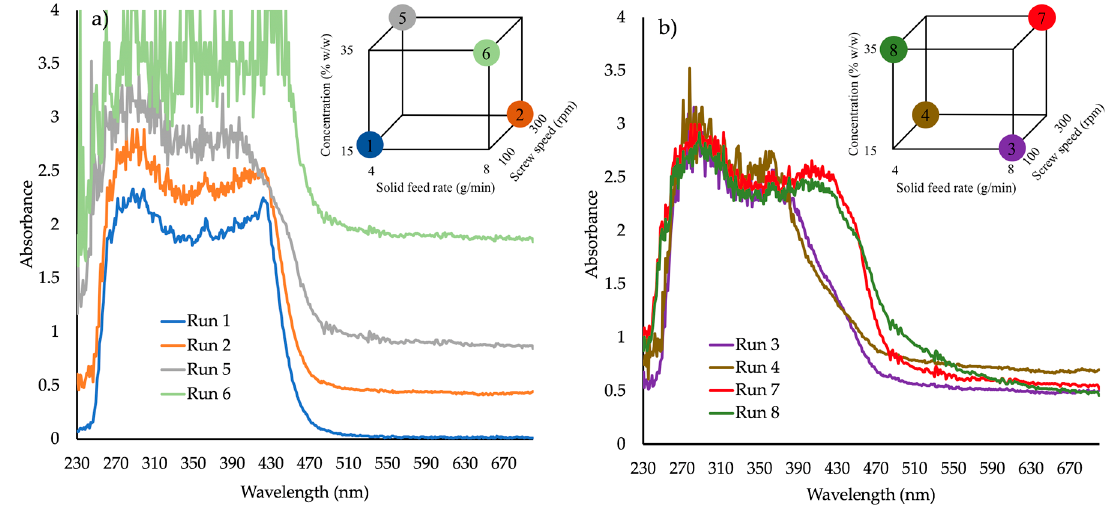
Figure 3. Absorbance vs. wavelength spectra for samples produced at ( a ) 150 °C and ( b ) 170 °C (DoE1, runs